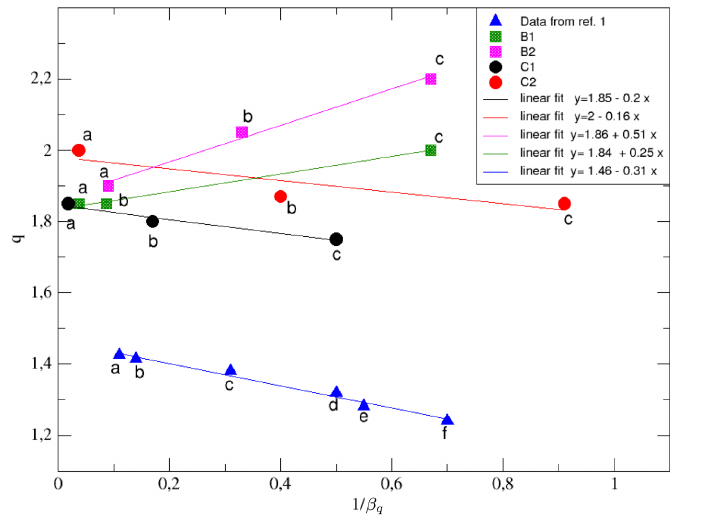
Figure 29. The values of the entropic index of the q -exponential fits, reproducing the complementary cumulative pdfs obtained from experimental data about the AE inter-event time series for both the concrete (C1, C2—full circles) and basalt (B1, B2—full squares) specimens, are reported as function of 1/ β q . Linear fits of the reported values are also shown. The macroscopic failure occurs when 1/ β q vanishes. The values for q and 1/ β q extracted from analogous failure tests with cement mortar specimens in [140] are also reported (triangles). From